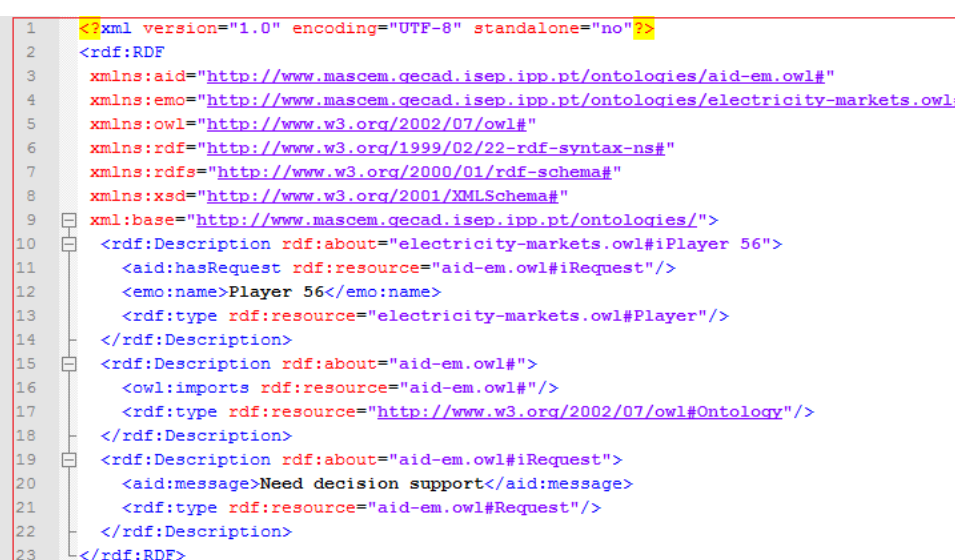
Figure 6. Player 56’s request for